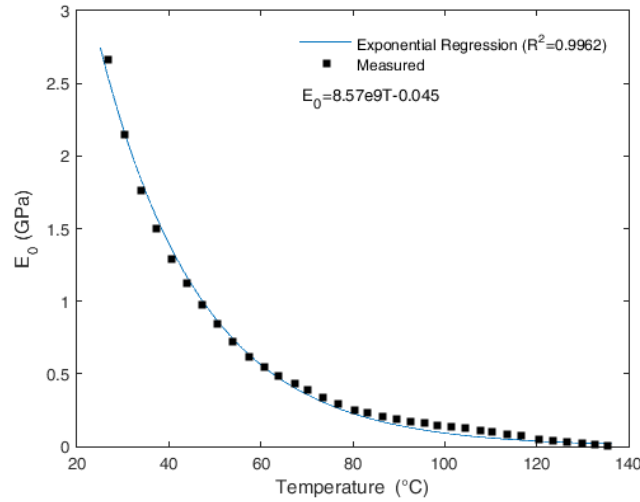
Figure 2. Variation of the POF static Young’s modulus with the temperature.